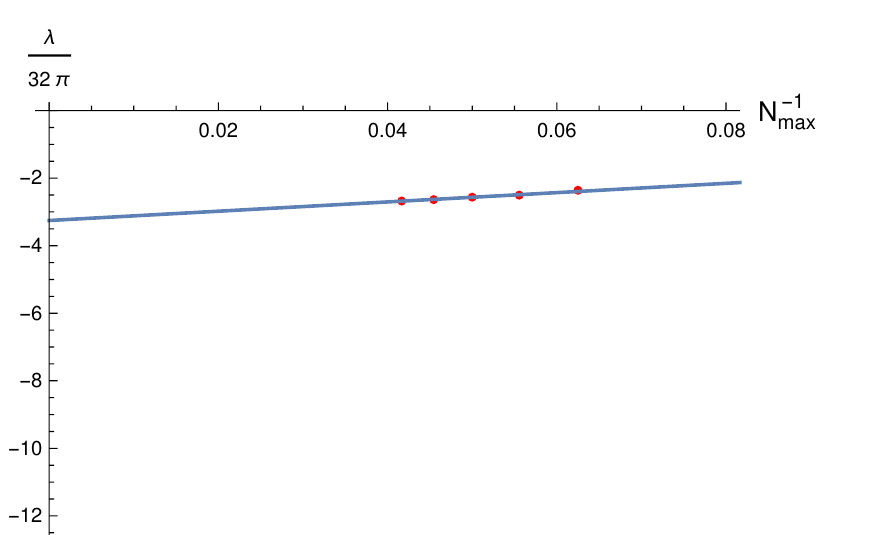
Figure 1 . Upper bound on the quartic coupling λ as a function of N − 1 are indicated by the red dots. They correspond to N max = 10 , 16 , 18 , 20 , 22 and 24 . The blue line represents the linear fit of the three points N max = 20 , 22 and 24 . It is described by λ/ (32 π ) = 1 . 74 − 6 . 02 N − 1 equation. The spin cut-off parameter used here is L max = N max + 20 . max